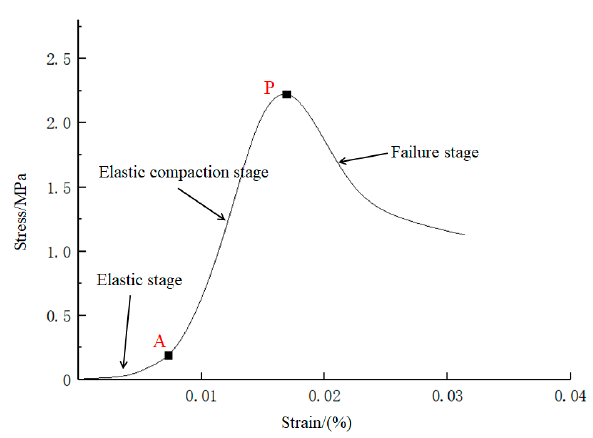
Figure 2. The stress–strain curve of grouting reinforcement.